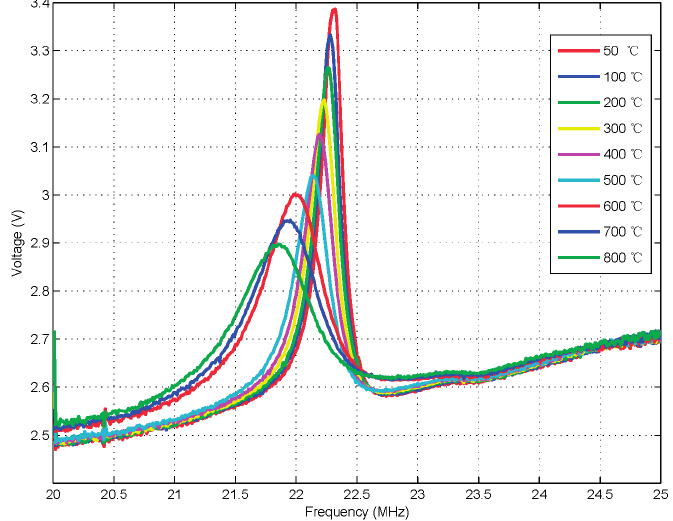
Figure 11. The measured output voltage versus frequency from 50 °C to 800